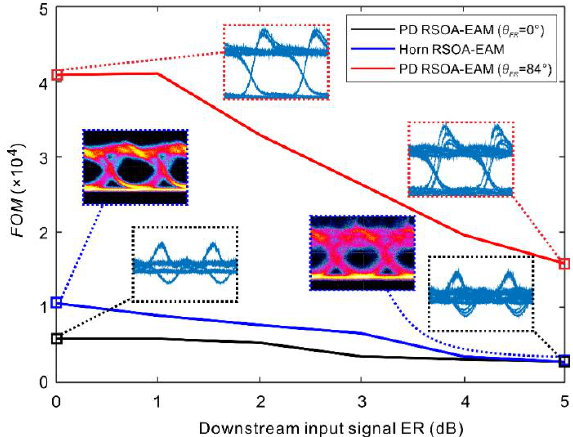
Figure 5. Dependence of ( a ) total gain P us / P in and Q 2 , and ( b ) figure of merit ( FOM ) on the rotation angle when the downstream input signal power is − 10 dBm. ( c ) One-way static gain characteristics along the downstream and upstream paths, respectively, with and without considering the XGS effect.